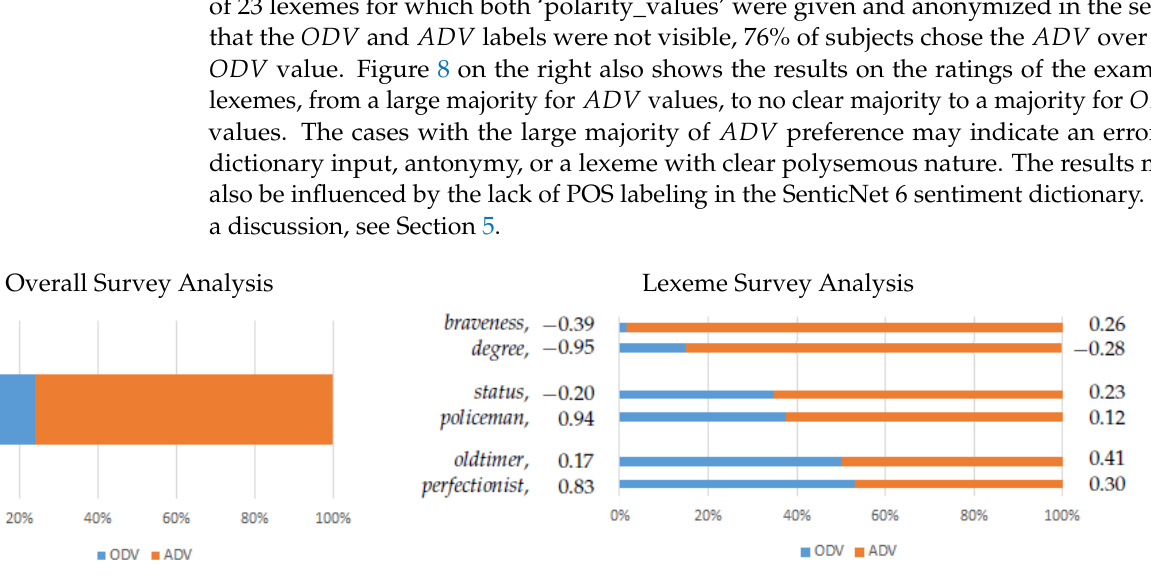
Figure 8. Survey Analysis on SenticNet 6 polarity_value ODV vs. ADV on example lexemes